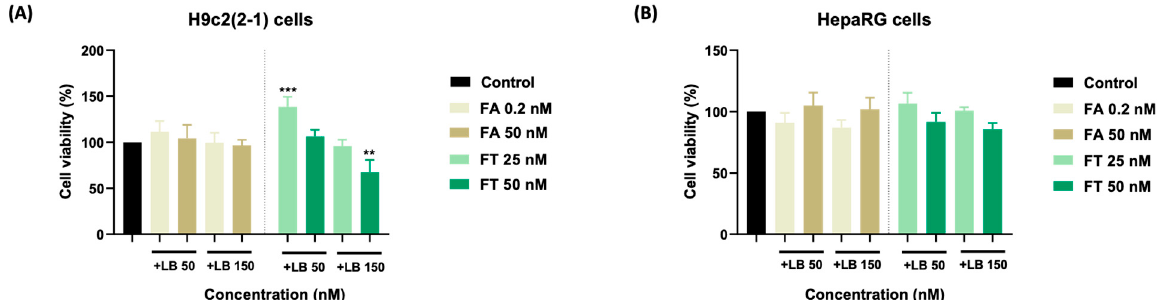
Figure 2. The impact of a 72-h treatment with LB–FA and LB–FT on the viability of ( A ) H9c2(2-1) cells and ( B ) HepaRG cells. The data are expressed as the mean values ± SD of three independent experiments performed in triplicate ( n = 3). The statistical differences between the control and the treated group were quantified by one-way ANOVA analysis followed by Dunnett’s multiple com- parisons post-test (** p < 0.01; *** p < 0.001).